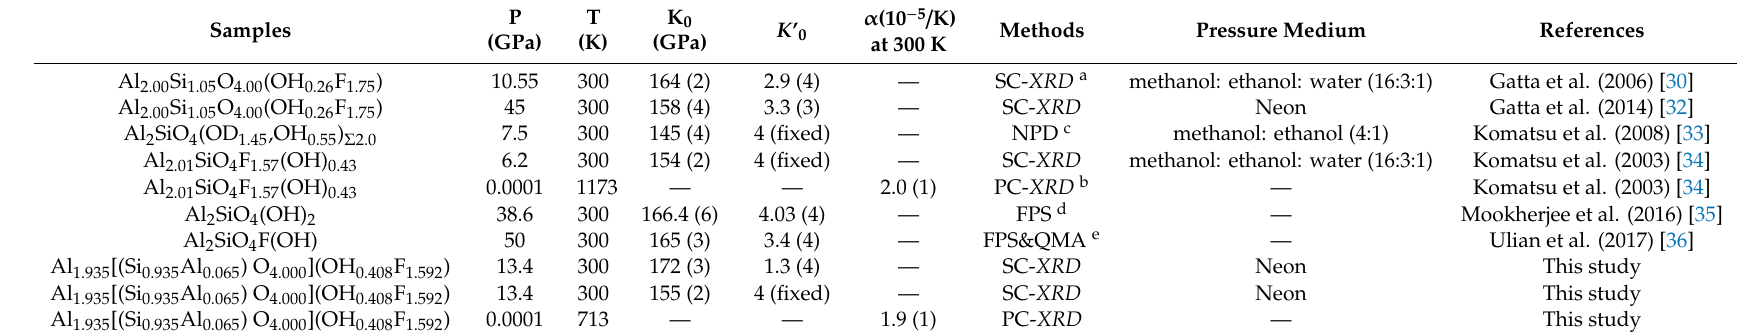
Table 4. Comparison of thermoelasticity of